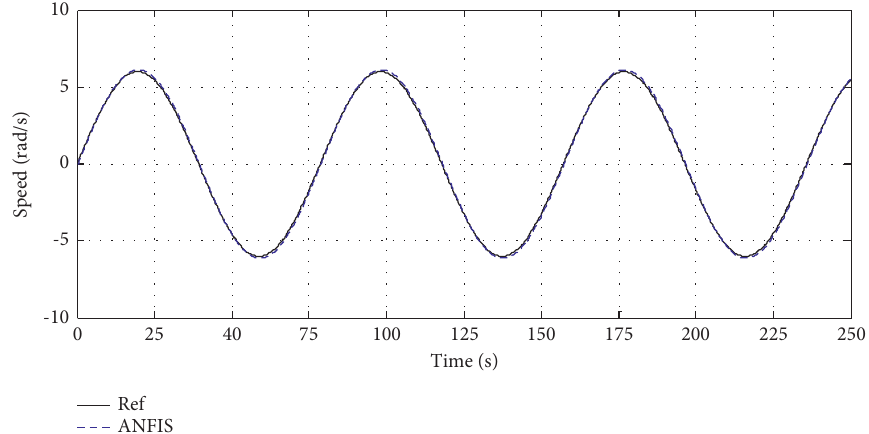
Figure 8: Reference speed and motor speed using an adaptive neural-fuzzy controller.